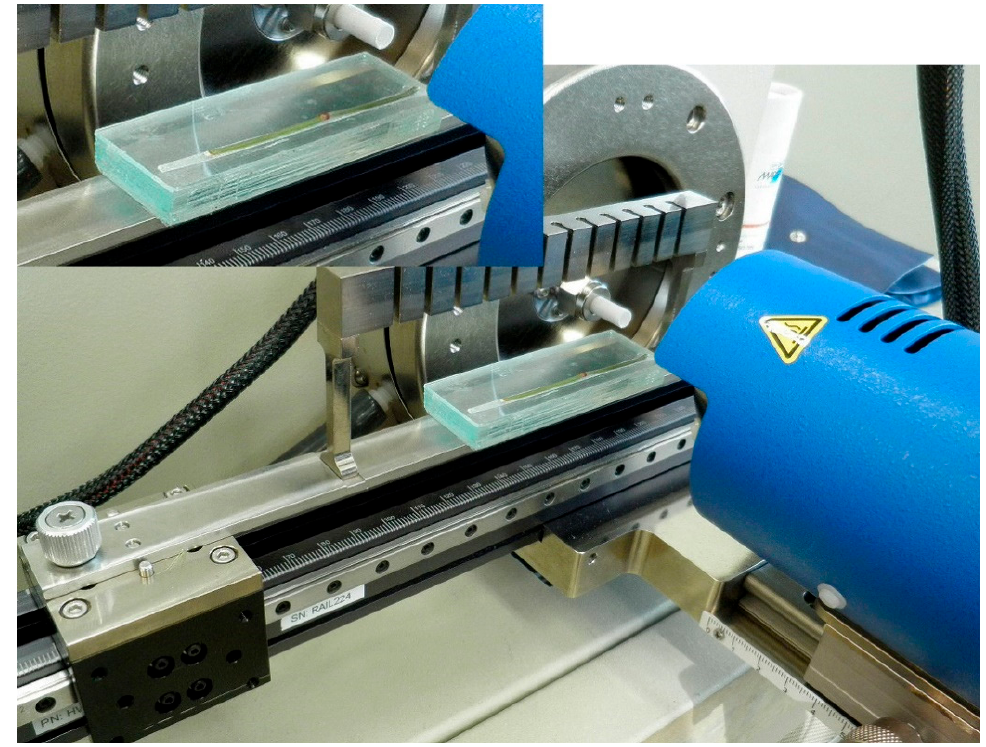
Figure 5. House-made sample module for DART-TOF-MS imaging system.